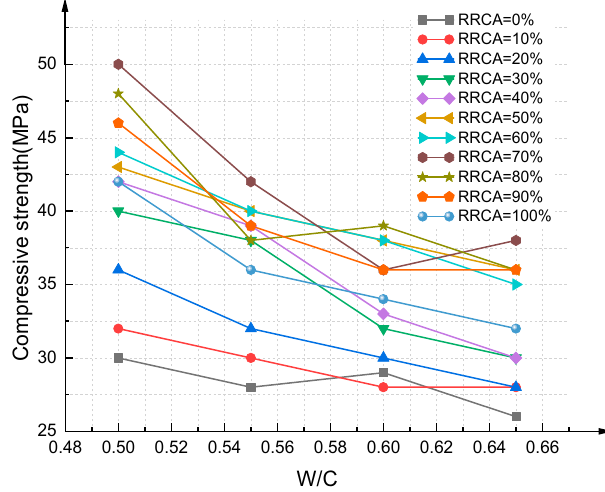
Figure 12. Compressive strength experiment results of RAC cube specimens (P1).